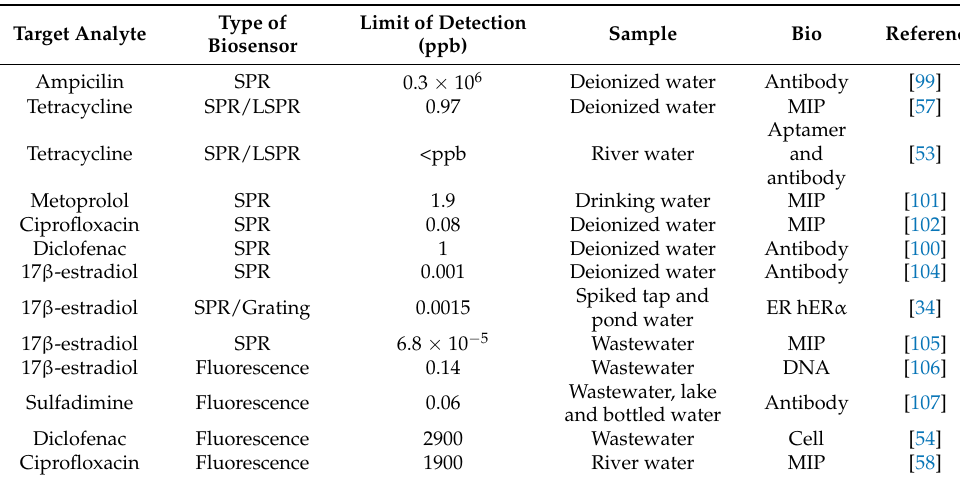
Table 3. Published work on detection of pharmaceutical compounds in water. Target